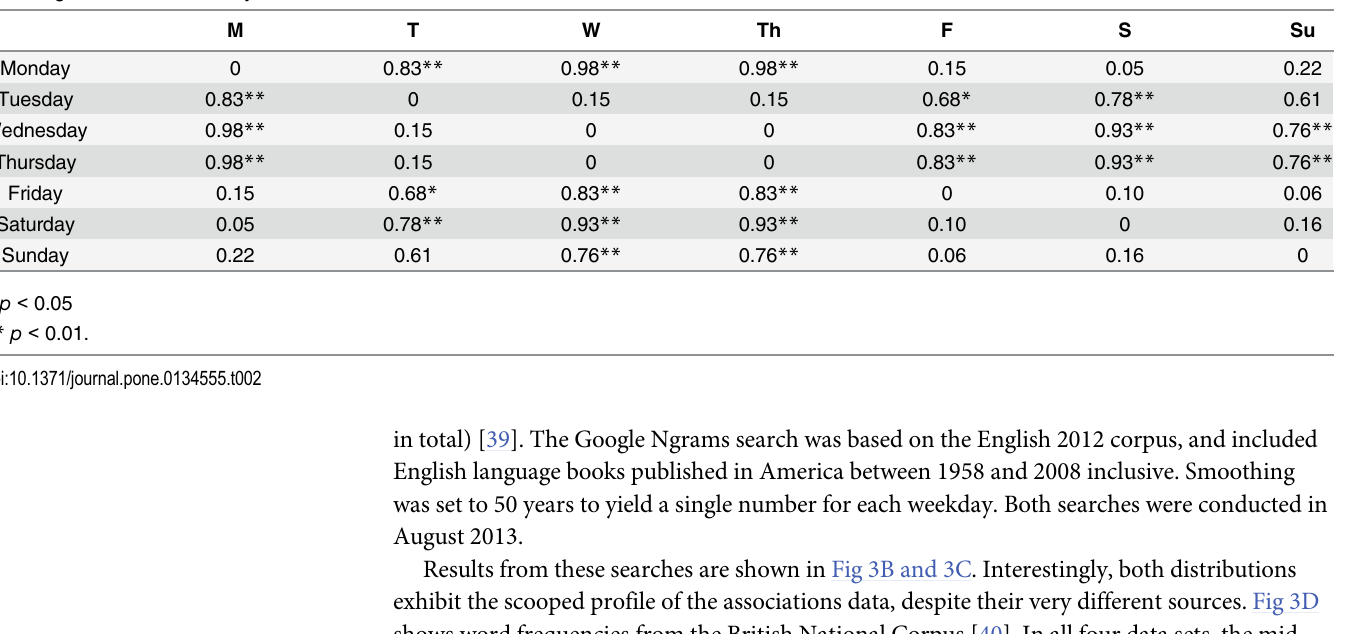
Table 2. Pairwise comparisons (with Bonferroni adjustment) between weekdays in Study 3. Cells contain absolute differences in the number of asso- ciations generated for each day.